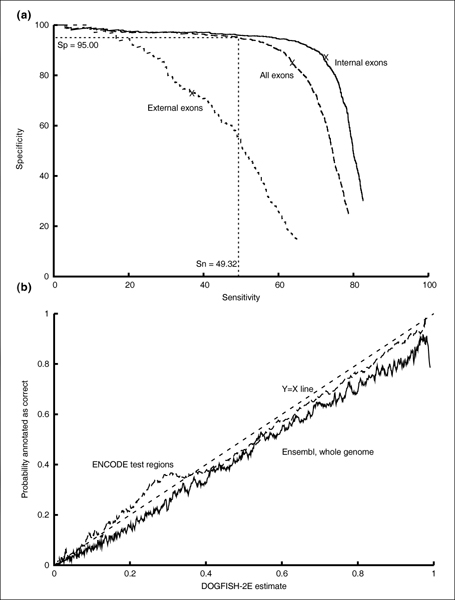
DOGFISH-2E results. (a) Sensitivity and specificity for DOGFISH-2E output. The figure shows plots for specificity against specificity on the ENCODE test regions as the acceptance probability threshold is varied for internal exons, external (initial and terminal) exons, and all exons together. 'X' is used to mark the DOGFISH-2 sensitivity and specificity values, and the specificity value of 95% for almost 50% sensitivity is highlighted. (b) Probability of annotation as a function of DOGFISH-2E estimate. The figure shows DOGFISH-2E probability estimates on the x axis and, on the y axis, the probability that a site a DOGFISH-2E estimate of the given magnitude is annotated in ENCODE and Ensembl, respectively. The Y = X line is shown for comparison.